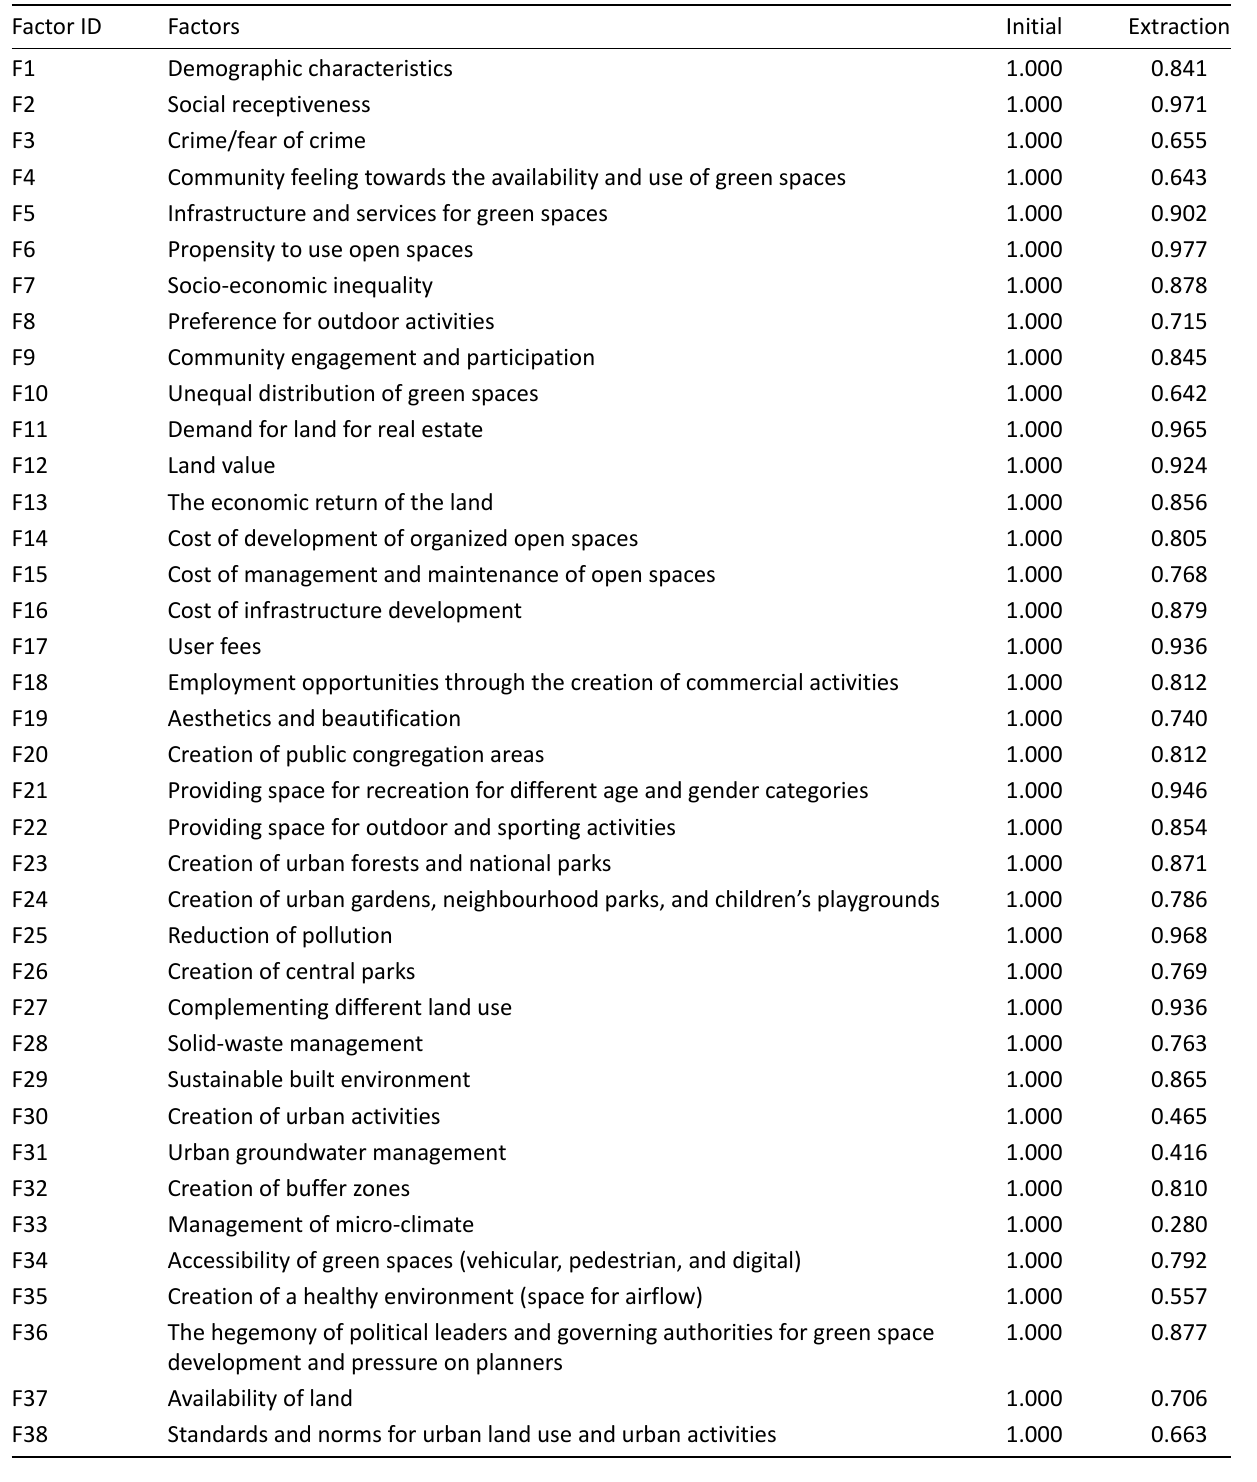
Table 4. Communalities indicating adequacy and factorability of the sample used for factor analysis. Factor